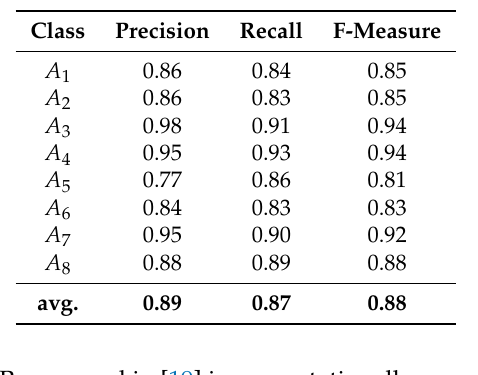
Table 5. Precision, Recall, and F-measure of the proposed model for position-independent and subject-dependent HAR.